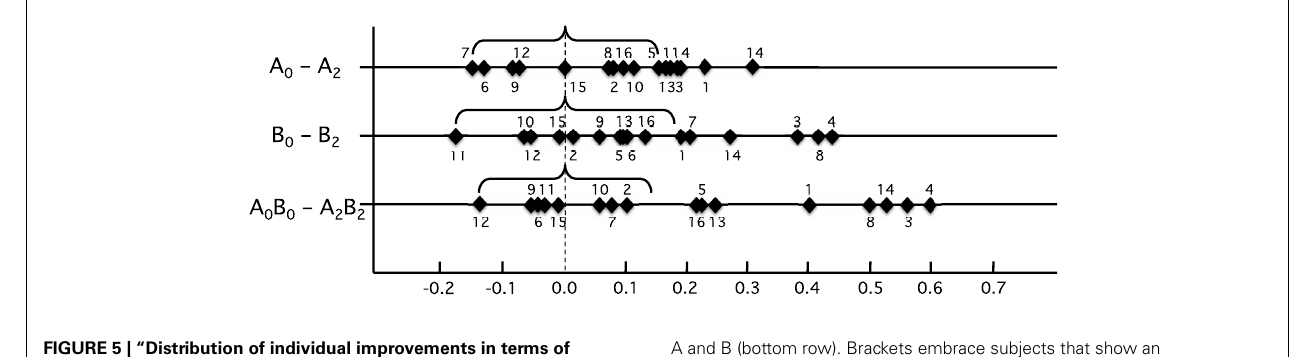
A and B (bottom row). Brackets embrace subjects that show an unsystematic pattern of learning; based on the assumption that subjects form a random distribution around the null-effect of training. Subjects characterized by highly positive AvgLoss differences (to the right of the brackets) provide evidence for a systematic effect of training.